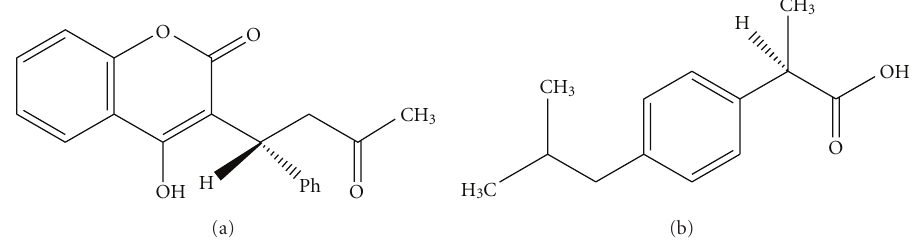
Figure 6: Chemical structures of warfarin (War, left) and ibuprofen (Ibu, right).